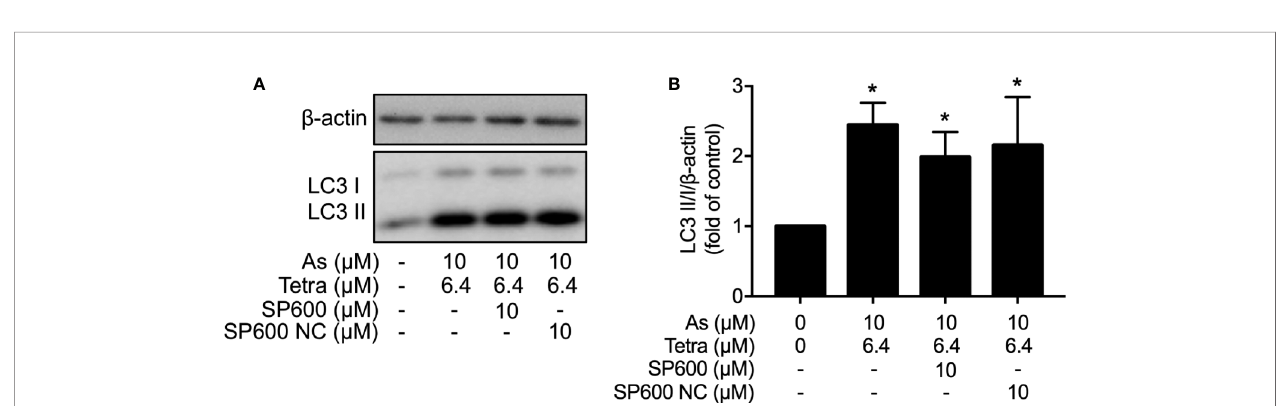
FIGURE 9 | Effect of SP600125 on the induction of autophagy in MDA-MB-231 cells treated with As III combined with Tetra. After treatment with 10 m M As III +6.4 m M Tetra in the presence or absence of 10 m M of SP600125 and its negative control SP600125NC for 48 h, the expression of LC3 protein was analyzed using western blot. (A) Representative images of the expression pro fi le of LC3 are shown from three independent experiments. (B) The relative expression level was expressed as the ratio between LC3 protein and b -actin protein expression levels, and compared with those of untreated control group. Results are shown as the means ± SD from three independent experiments. *p<0.05 vs. control. As, As III ; Tetra, tetrandrine; SP600, SP600125; SP600 NC,